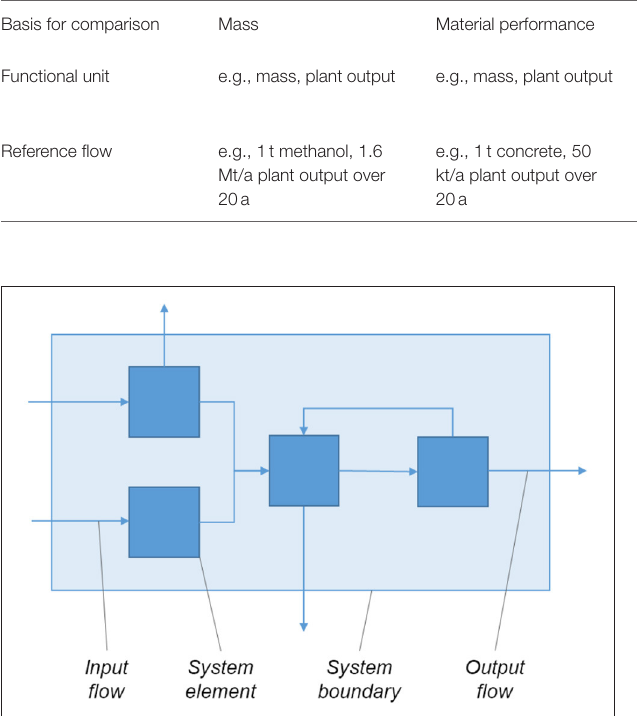
FIGURE 3 | An exemplary product system with its elements, boundaries, input, and output flows.